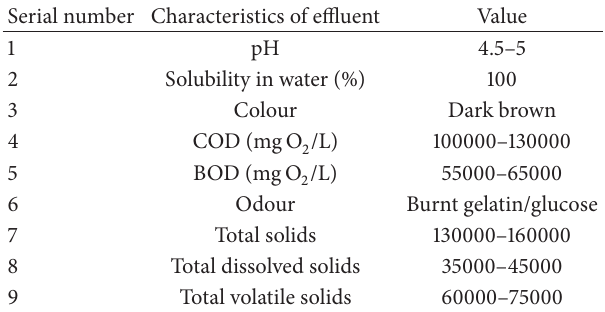
Table 1: Characteristics of distillery industry spent